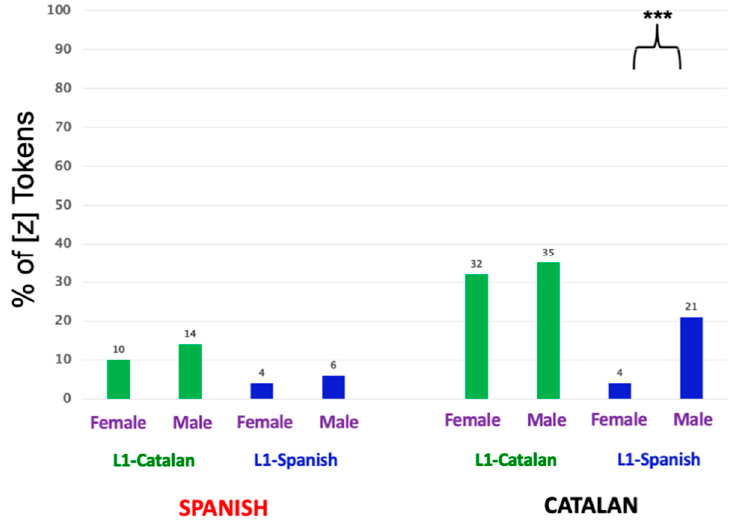
Figure 9. Effect of gender as mediated by language profile and language on Valencian fricative production.